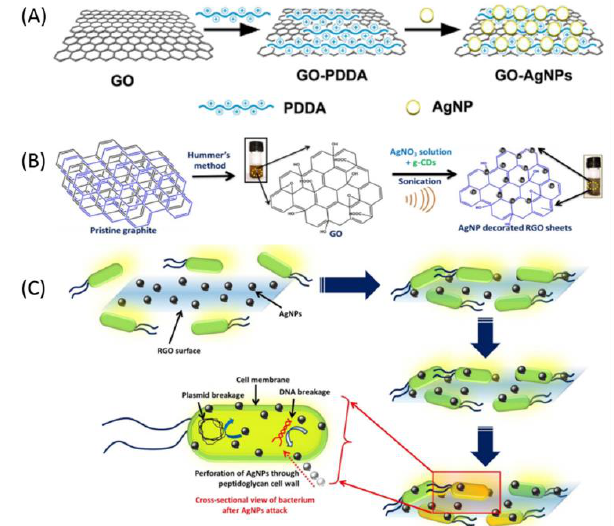
Figure 2. ( A ) Schematic representation of the self-assembly of PDDA and AgNPs onto GO